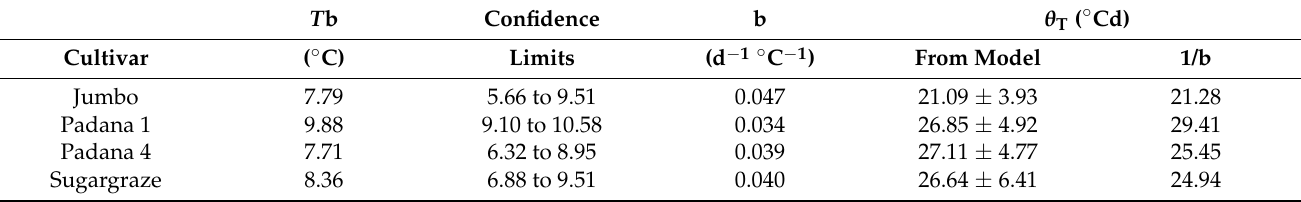
Table 6. Values of base temperature ( T b), b coefficient of linear regression of GR 50 vs. T , estimated (from the model, ± σ ) and calculated (inverse of the slope b) thermal time θ T , in thirty cultivars of sorghum. Confidence limits for T b are reported. T b Confidence b θ T ( ◦ Cd) Cultivar ( ◦ C) Limits (d − 1 ◦ C − 1 ) From